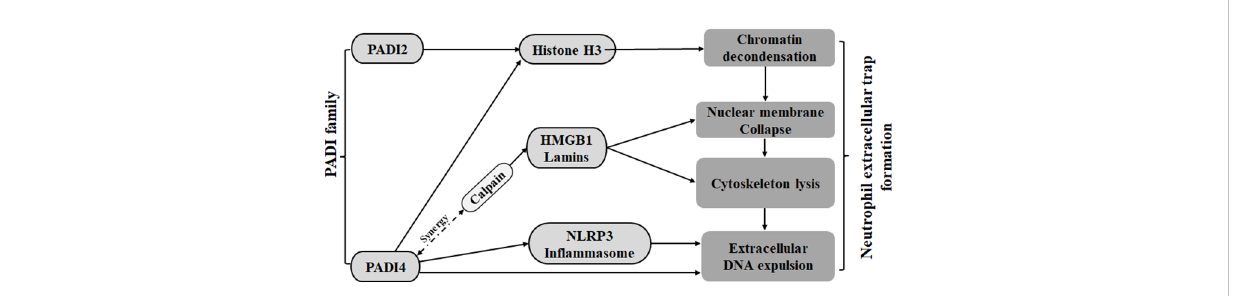
FIGURE 1 The PADI family promotes the formation of neutrophil traps. Both PADI2 and PADI4 can cause chromatin depolymerization by acting on histone H3. PADI4 can cooperate with calpain on HMGB1 and lamins to cause nuclear membrane disruption. PADI4 can also mediate nuclear membrane disruption and cytoskeleton fragmentation by promoting nucleosome